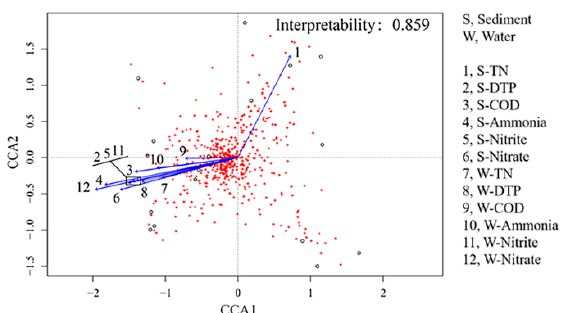
Figure 4. The relationships between environmental factors and bacterial community structure (genus level). Environmental factors include six physicochemical indexes (ammonia, nitrite, nitrate, total nitrogen (TN), dissolved total phosphate (DTP) and chemical oxygen demand (COD)); each was determined in sediments (S) and water column (W); “S” and “W” are used as prefixes to distinguish these indicators.